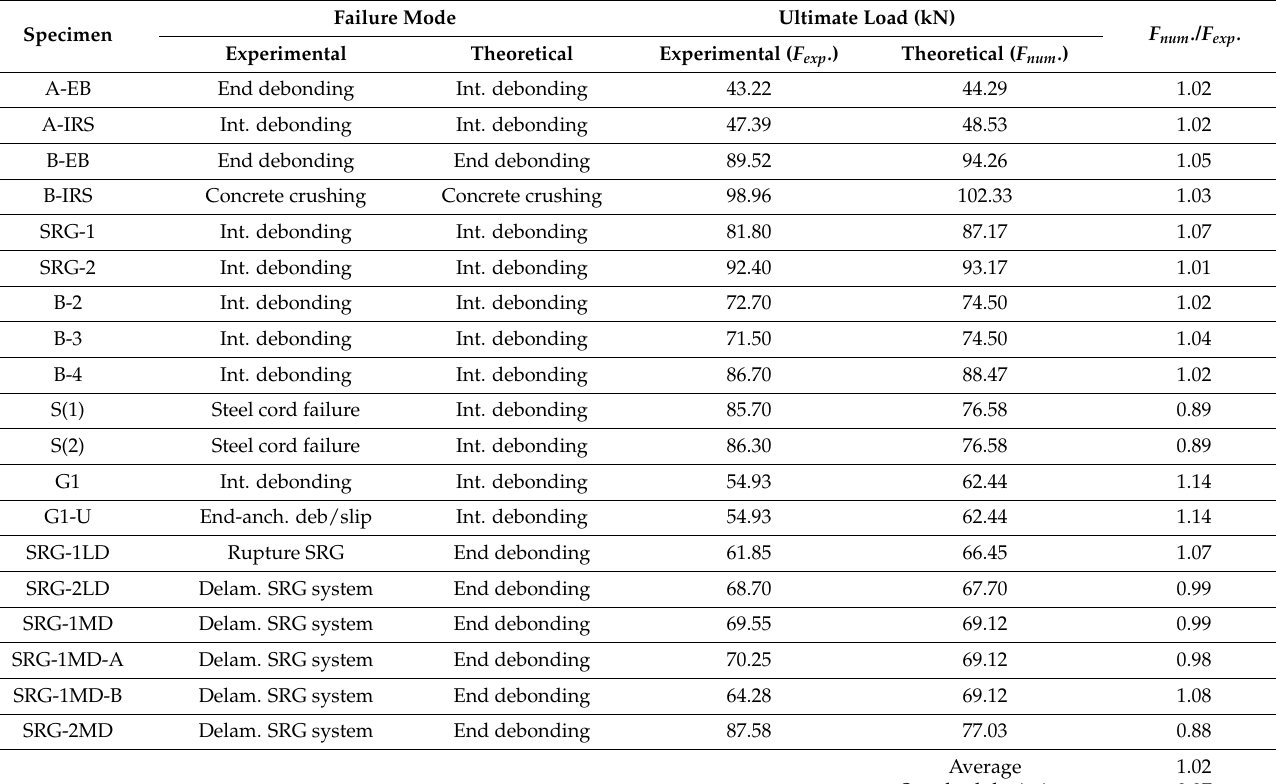
Table 2. Theoretical/experimental